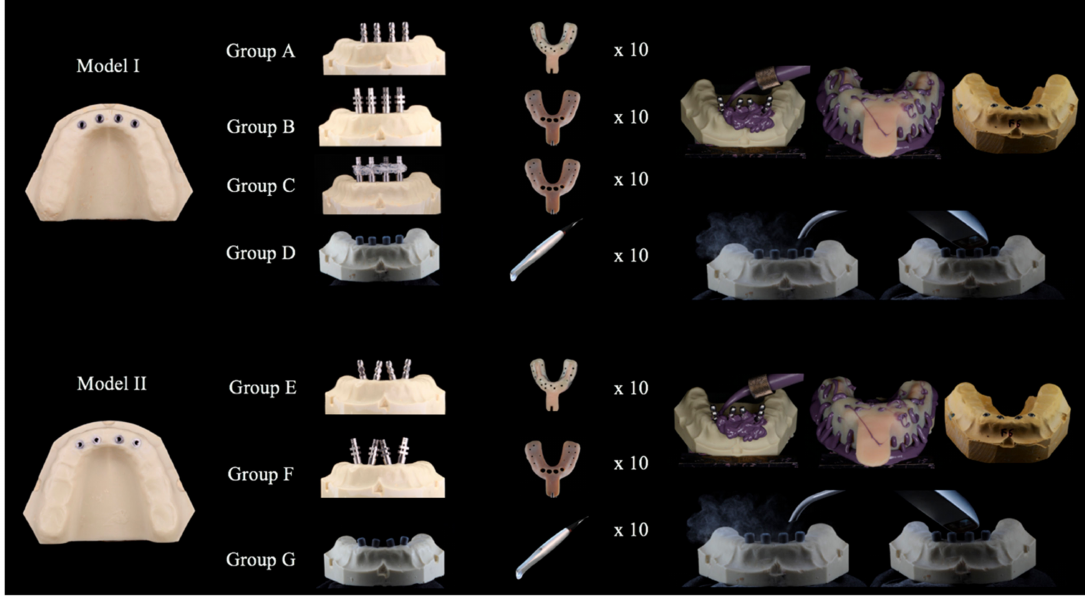
Figure 3. Impression protocol—obtaining study